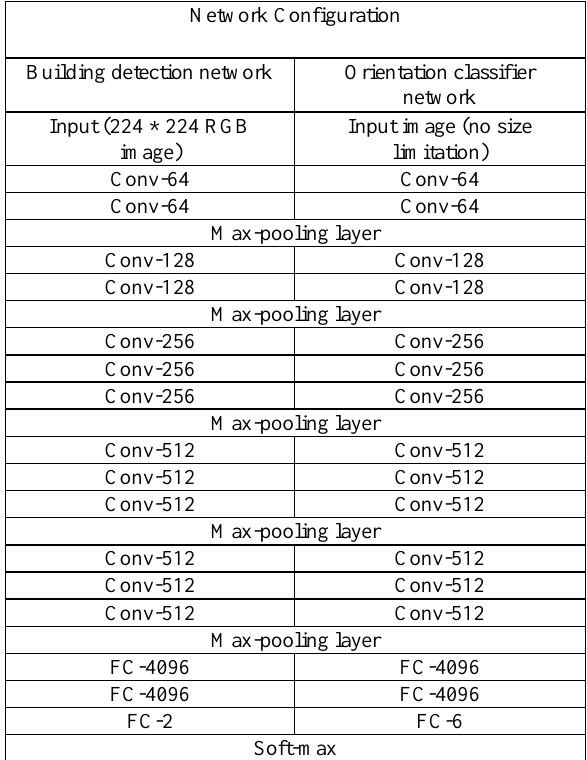
Table 1. Building detection network configuration